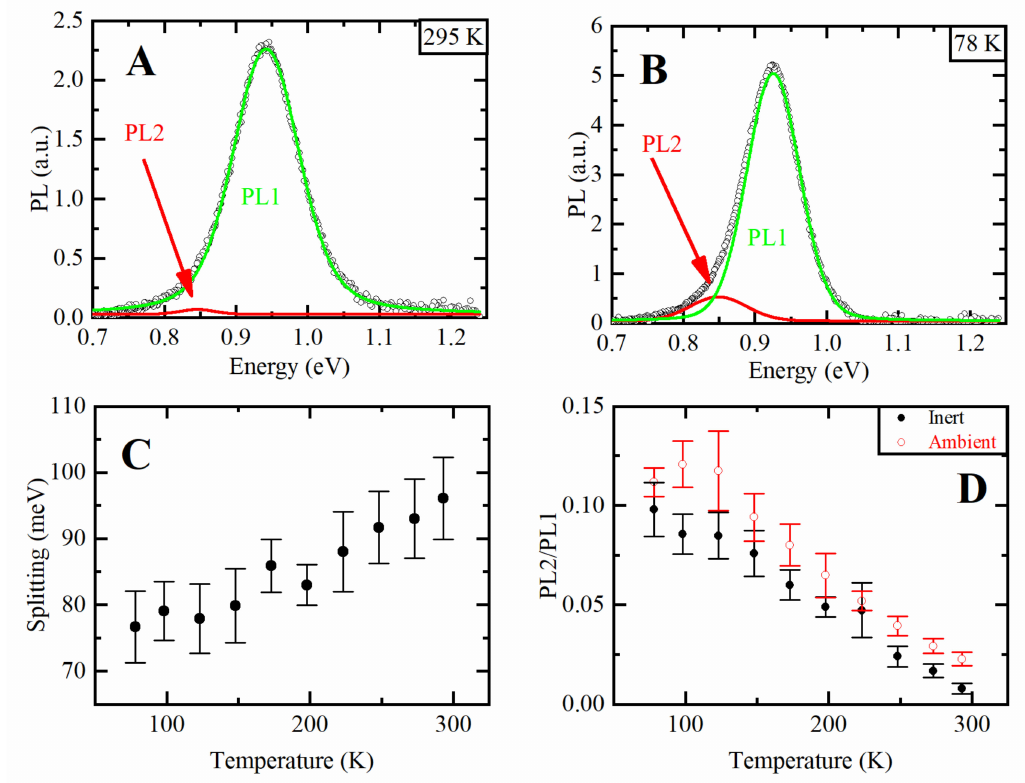
Figure 2. PL spectra of 4 ML PbSe NPLs at ( A ) 295 K and ( B ) 78 K, green line stays for PL1, red line—for PL2; ( C ) energy splitting between PL1 and PL2 peak positions; ( D ) ratio of PL2 to PL1 areas, black dots—NPLs purified in inert atmosphere, red dots—NPLs purified in ambient